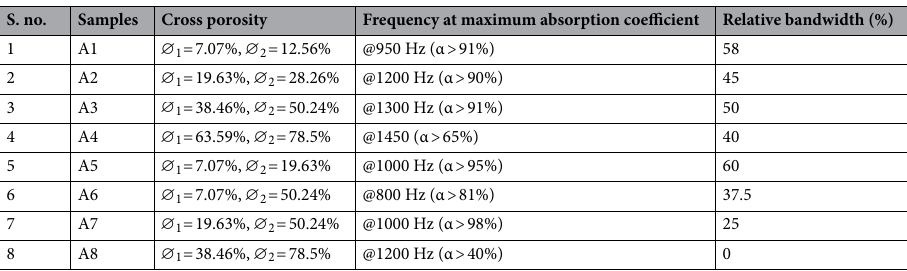
Table 1. Fractals CMPPs metamaterials parameters and its acoustic absorption behavior of a unit cell.